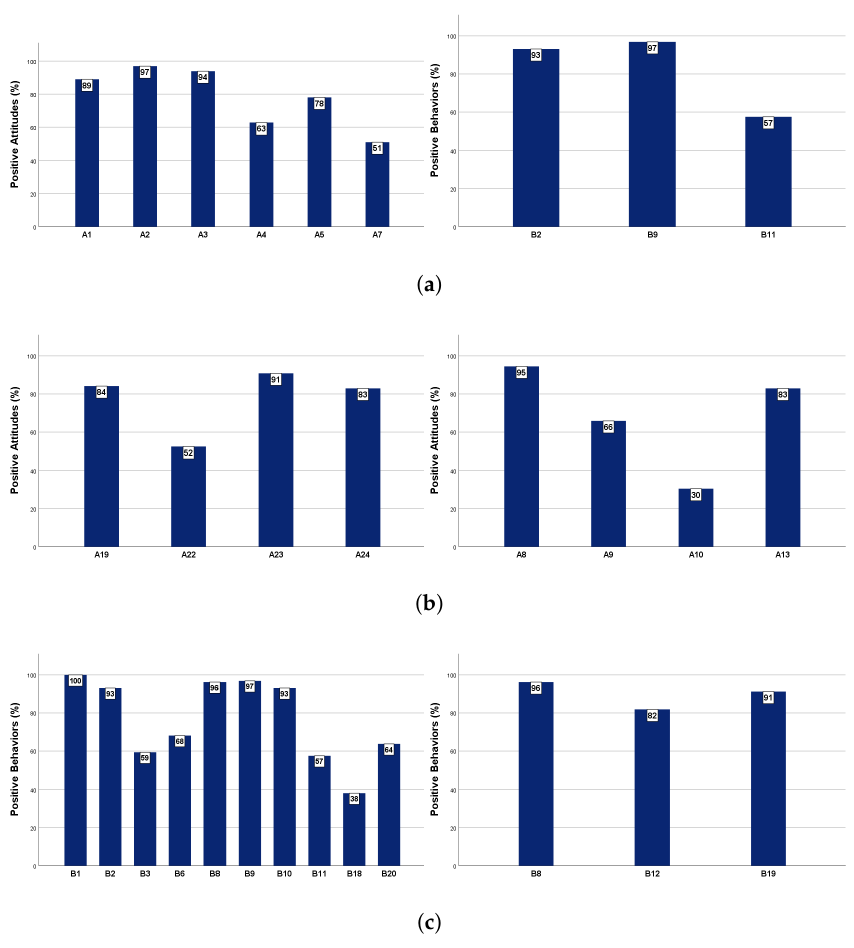
Figure 7. Findings: attitudes and behaviors. ( a ) Finding 05—attitudes and behaviors. ( b ) Findings 06 and 07—attitudes. ( c ) Findings 08 and 09—behaviors.